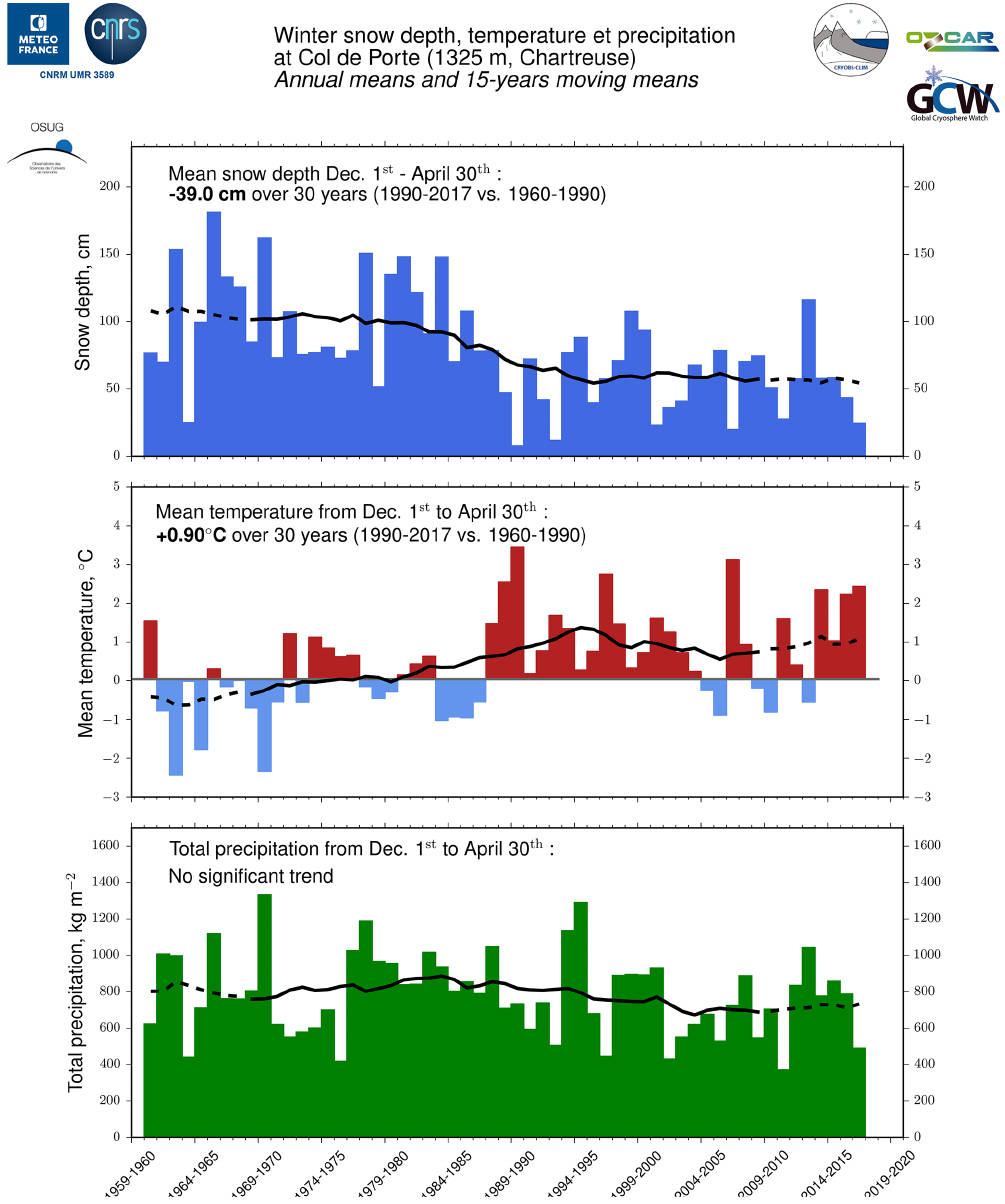
Figure 11. Evolution of mean snow depth, air temperature, and total precipitation over 1960–2017. The mean and total values are calculated over the period of 1 December to 30 April for each snow season. The black lines are 15-year moving means. Figure adapted from Dumont et al.